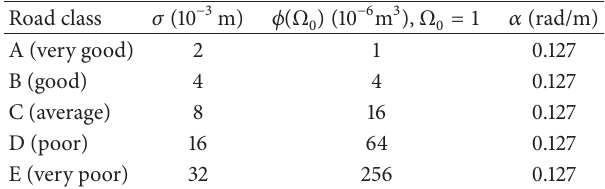
Table 2: Road roughness and standard deviation